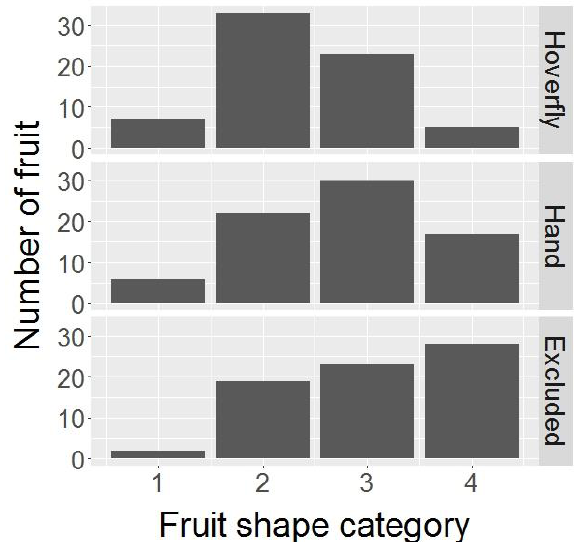
F IGURE 2. Fruit shape category frequency distributions by pollination treatment (1 = highly symmetrical fruit with no malformations; 2 = slightly asymmetrical fruit with minimal malformations; 3 = fruit with clear asymmetry and/or some malformations; 4 = fruit with major malformations). Fruit that fell into category 3 or 4 were deemed